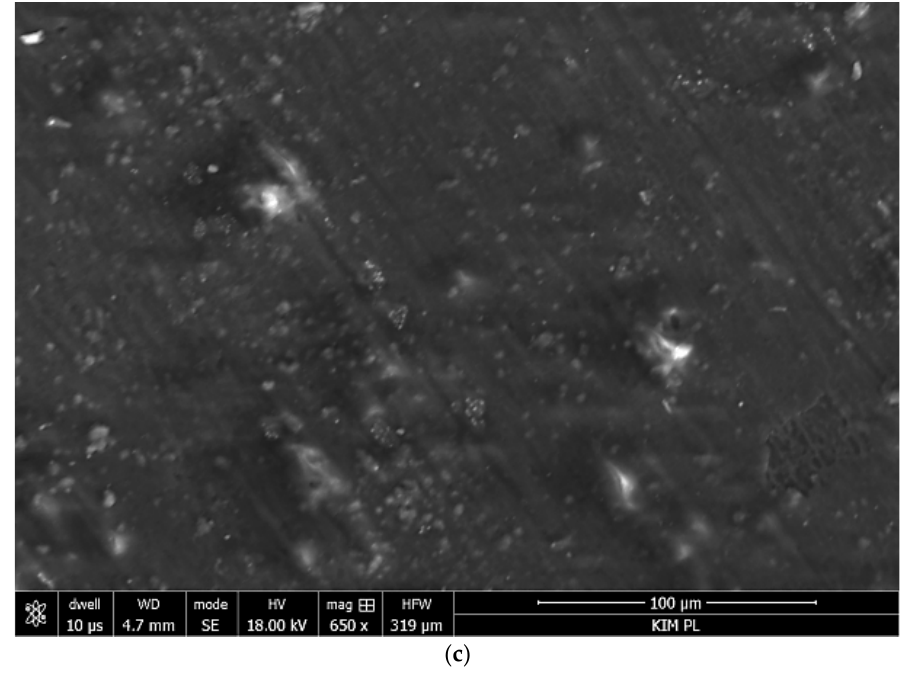
Figure 4. Microstructure of the coatings on aluminum surface after the potentiodynamic test: ( a ) single-layer coating, ( b ) double-layer coating, and ( c ) triple-layer coating; 0.5 M NaCl solution; SE images SEM.